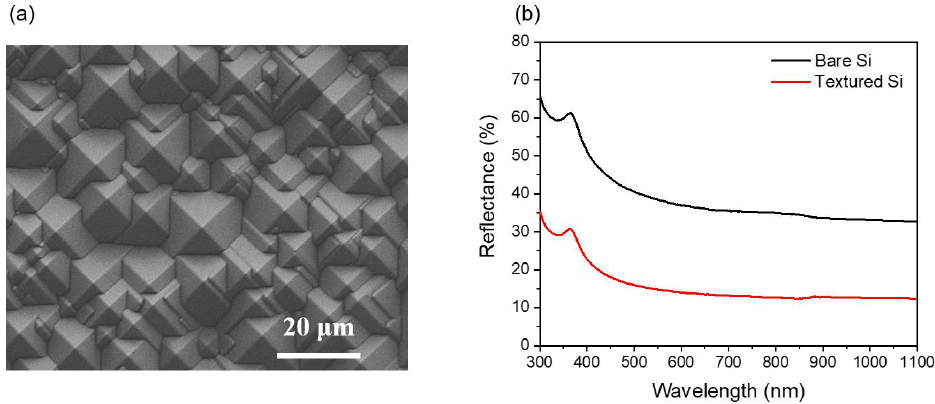
Figure 6. ( a ) SEM image of randomly textured Si backside. ( b ) The reflectance curves of bare Si wafer and textured Si in the wavelength range of 300 – 1100 and textured Si in the wavelength range of 300 – 1100 nm.